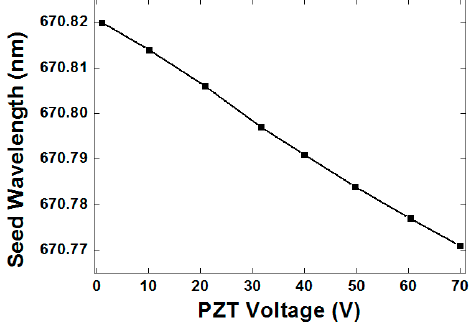
Figure 4. The wavelength tuning versus PZT piezoelectric ceramic control voltage.